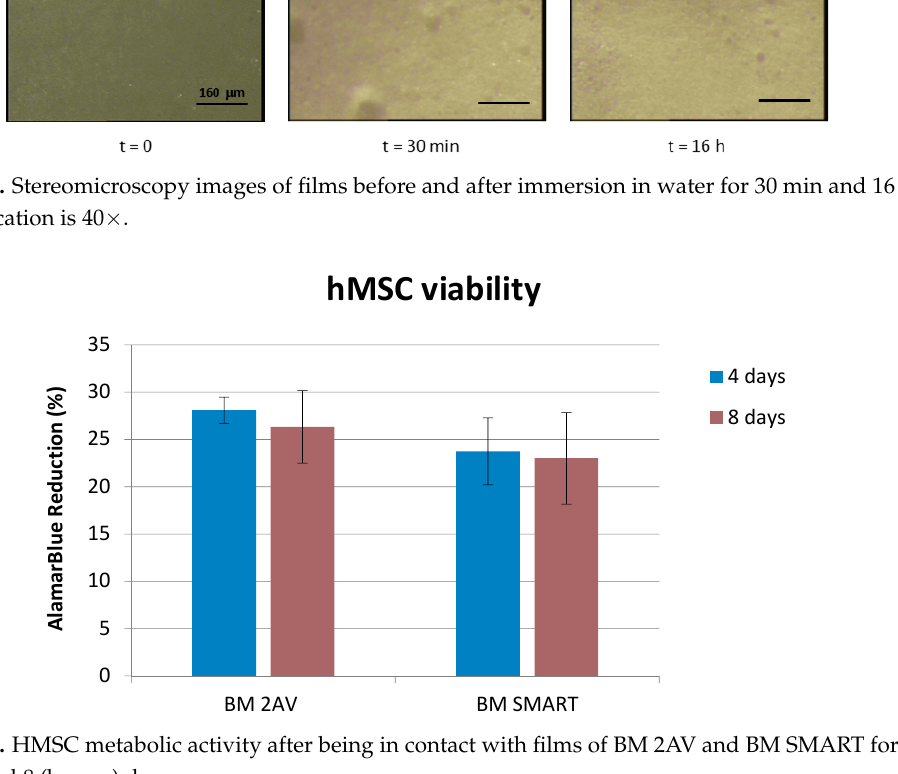
Figure 8. SEM micrographs of BM 2AV and BM SMART films cultured with hMSCs under basal (undifferentiated) and osteodifferentiated conditions. The results of gene expression analysis by keratinocytes (Figure 9) showed that BM SMART possessed a significant immunomodulatory activity; indeed, it was capable of upregulating the expression of both pro-and anti-inflammatory cytokines (with the exception of IL-6) but it did not upregulate the expression of antimicrobial peptide hBD-2.